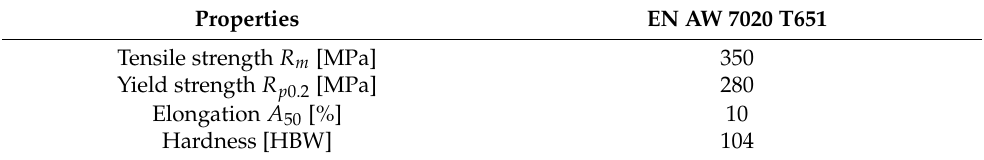
Table 4. Mechanical properties of EN AW 7020 T651 by DIN EN 485-2 [11,12].